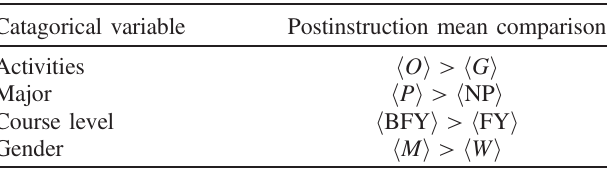
TABLE V. Comparison of postinstruction means as adjusted by the 5-way ANCOVAs for each categorical variable. A difference between group means is indicated only when that difference was statistically significant. Here, h O i is the predicted postinstruction mean for students in courses using open-ended activities and similarly for students in courses using only guided activities h G i , physics students h P i , nonphysics students h NP i , men h M i , women h W i , BFY students h BFY i , and FY students h FY i . Variables are listed in descending order by size of the difference in adjusted postinstruction means between groups.